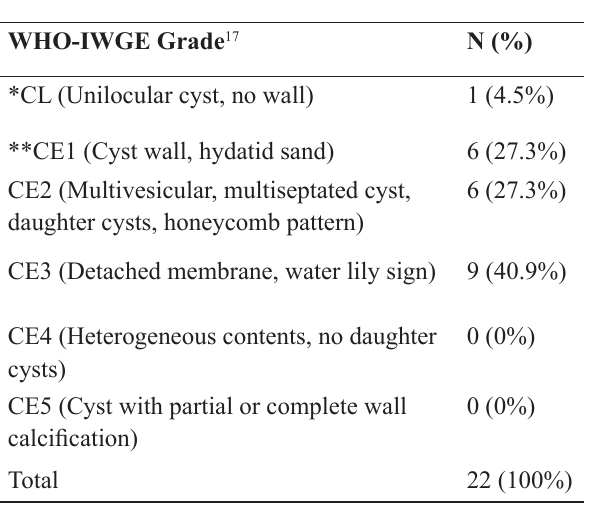
Table 3. WHO-IWGE Grading of